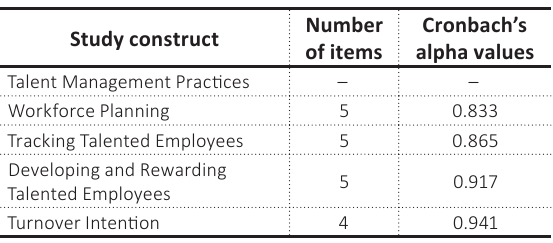
Table 4. Cronbach’s alpha